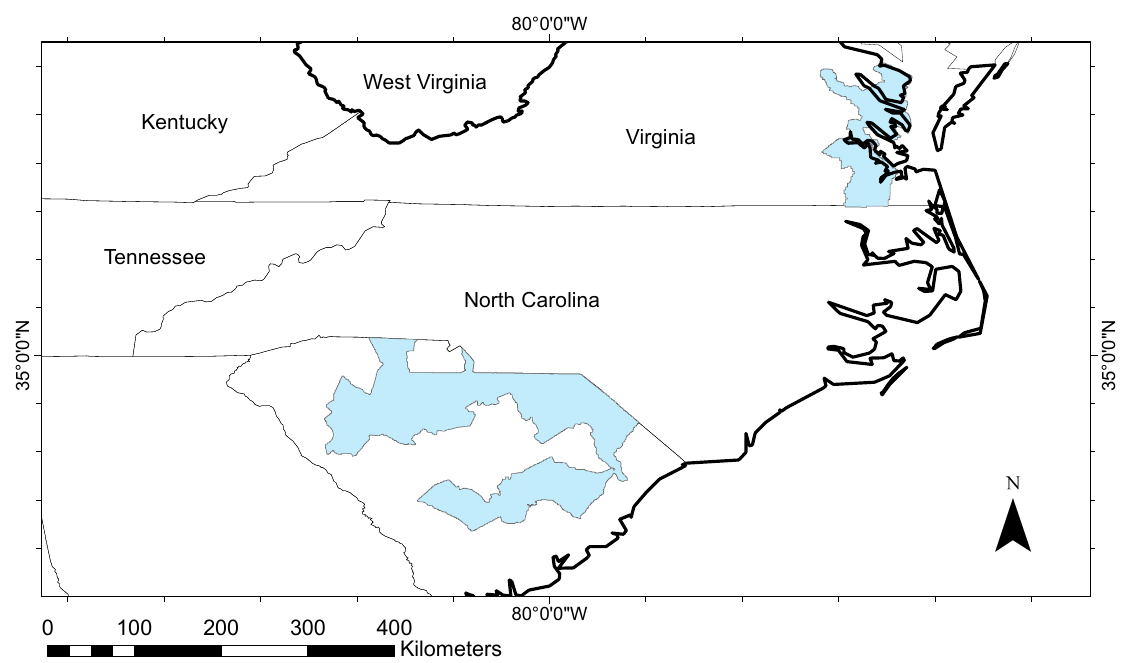
Figure 4. The extents of the two ALS projects over which the site index mapping was done are shown in blue shading. This represents an approximate area of 33,840 sq. km.